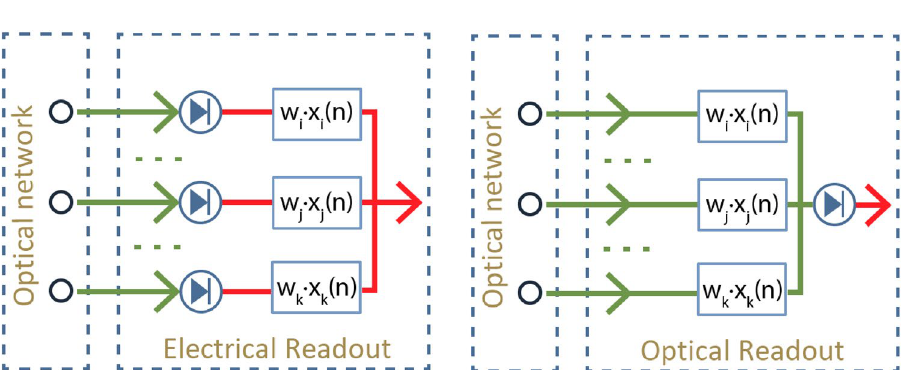
Figure 2. (Left) electrical readout. (Right) optical readout. Green lines represent optical signals, and red lines electrical signals. A crucial difference is the order of the summation and